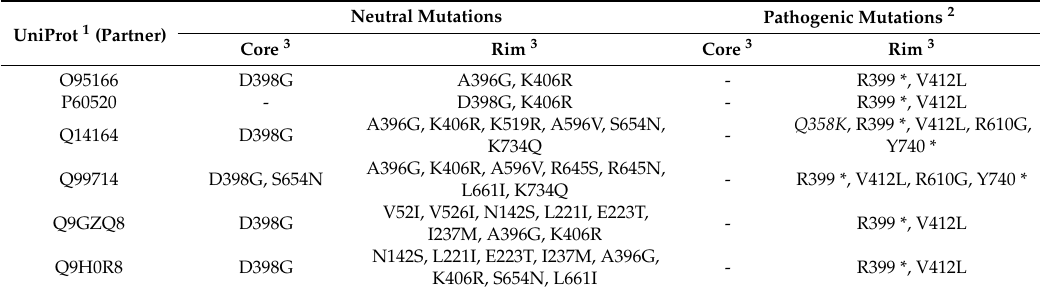
Figure 4. Docking-based characterization of HADHA mutations related to protein interactions. ( a ) Neutral (yellow) and disease-related (purple) mutations mapped on HADHA structure. In panels ( b – g ), docking-based predicted interface core (red) and rim (green) residues in HADHA for the interaction with the following partners: ( b ) O95166, ( c ) P60520, ( d ) Q14164, ( e ) Q99714, ( f ) Q9GZQ8, and ( g ) Q9H0R8. Table 3. Docking-based characterization of HADHA mutations .